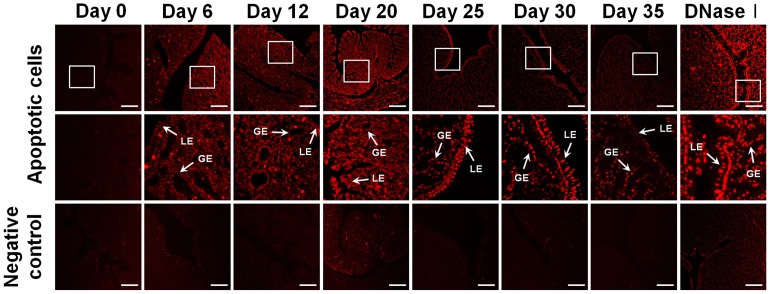
TUNEL (TdT-Mediated dUTP Nick End Labeling) stained cells in the magnum of hens fed a high zinc diet or a normal diet.Endogenous DNA fragmentation in nuclei of cells indicates programmed cell death. For positive controls, tissues were incubated with DNase I prior to labeling procedures. For negative controls, tissues were incubated only in the label solution instead of TUNEL reaction mixture. Images were captured at 20× (top) and 40× (middle) magnification. Legend: LE, luminal epithelium; GE, glandular epithelium; Scale bar represents 50 µm.